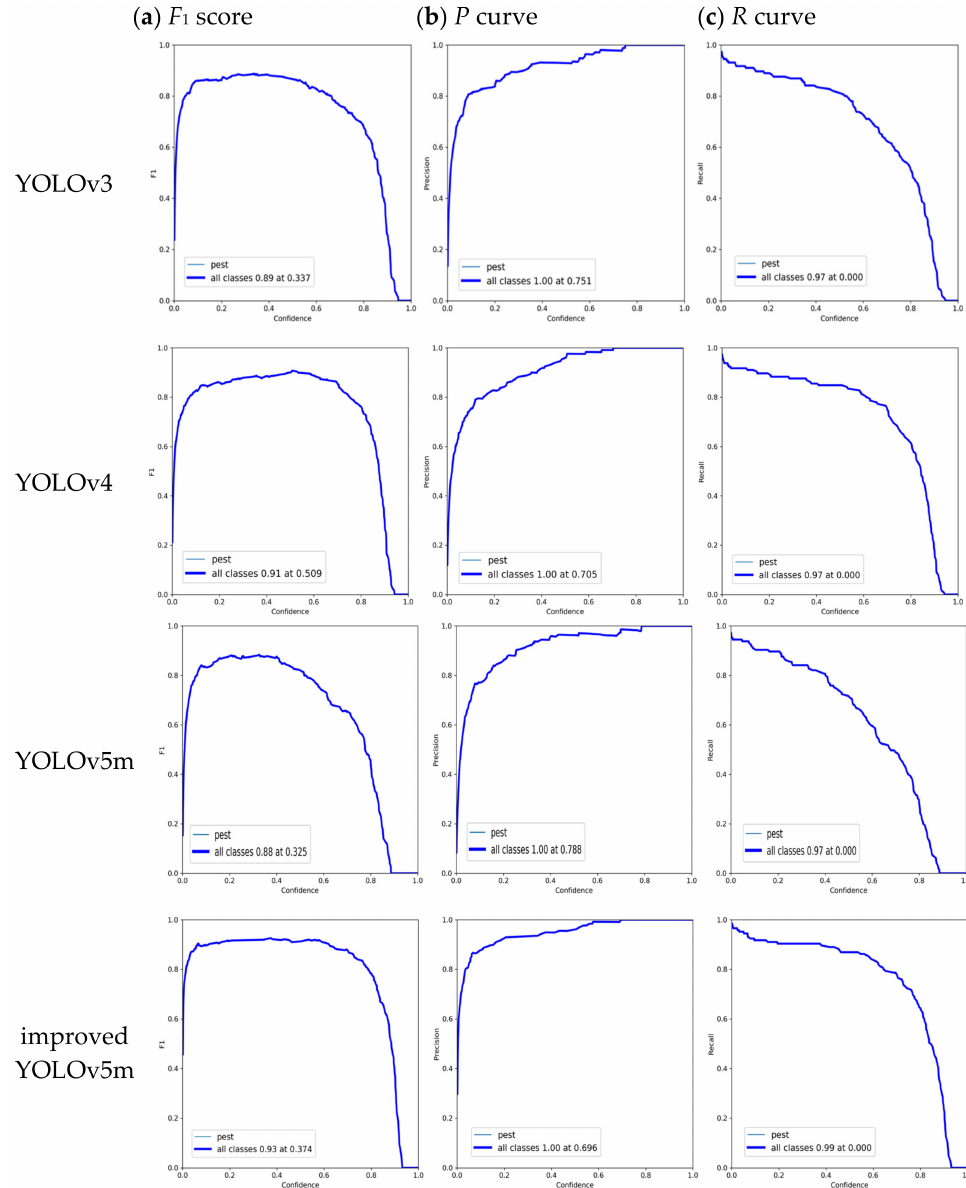
Figure 9. Comparison results of different YOLO models (YOLOv3, YOLOv4, YOLOv5m, and improved YOLOv5m) regarding performance indicators over confidence, including ( a ) F 1 score, ( b ) P curve, and ( c ) R